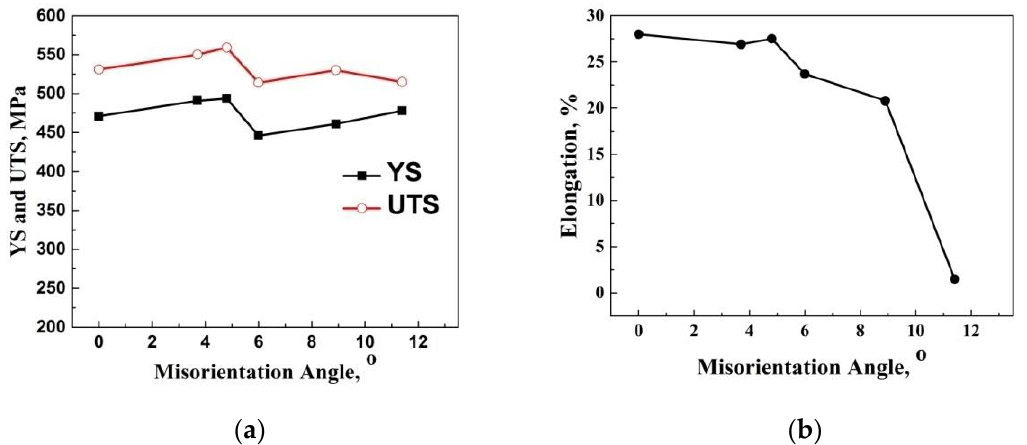
Figure 4. Relationship between the tensile properties of DD9 alloy and the misorientation angles of the LABs at 1100°C: ( a ) YS and UTS; ( b ) elongation.